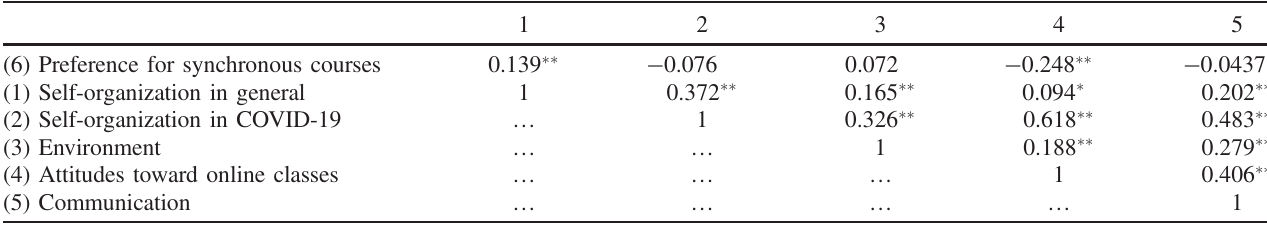
TABLE VII. Correlation analysis. Significant correlation coefficients are indicated by (cid:3) ð p < 0 . 05 Þ and (cid:3)(cid:3) ð p < 0 . 01 Þ , respectively.